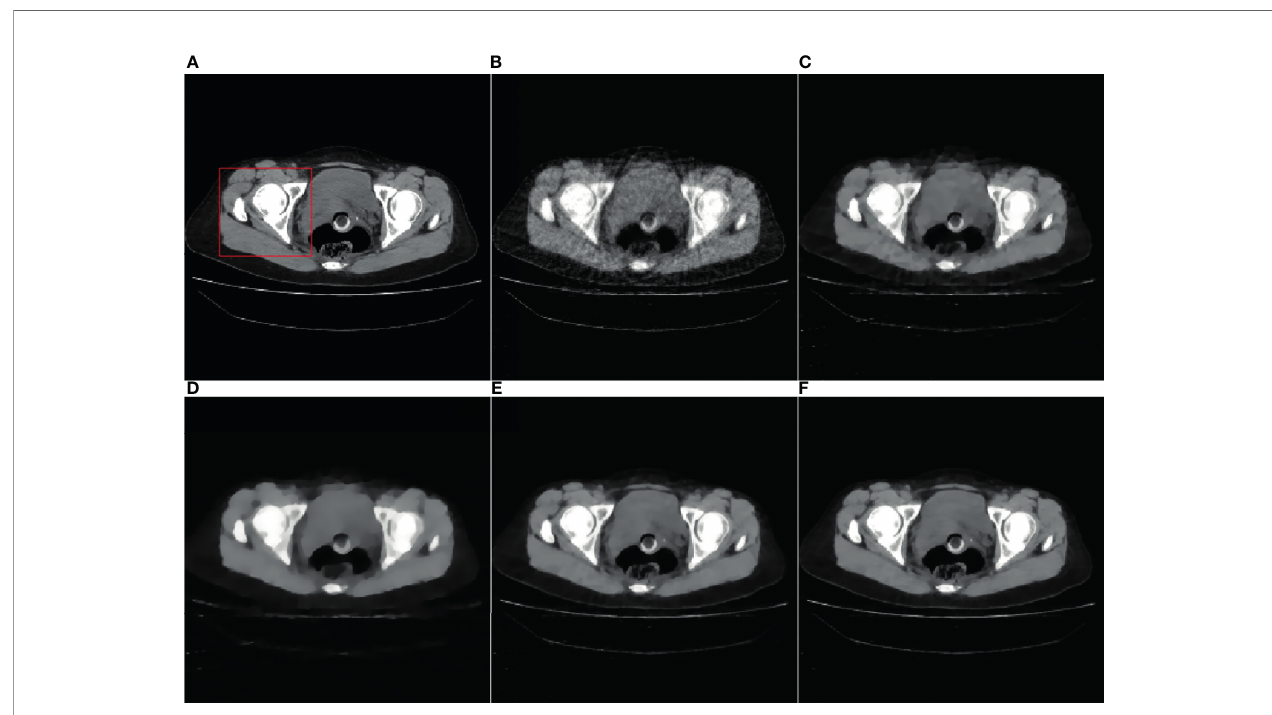
FIGURE 4 | 40th slice reconstruction result: (A) reference image; (B) SART; (C) ASD-POCS; (D) SART-TV; (E) TpV; (F)